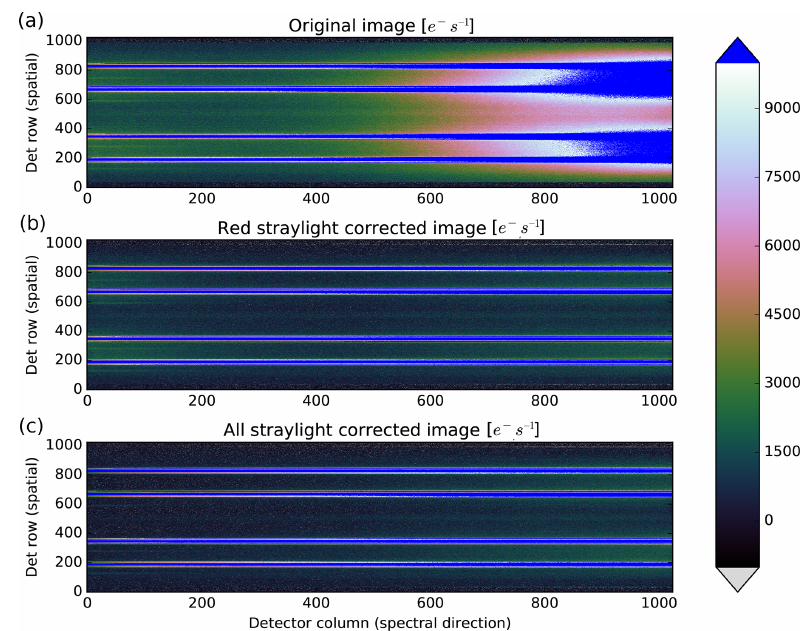
Figure 28. Validation measurement with fibres 2, 4, 8, and 10 illuminated by the integrating sphere. (a) NIR detector image before correction. (b) Image after correction for straylight from the red (long wavelength) side only. (c) Image after out-of-band straylight correction for both